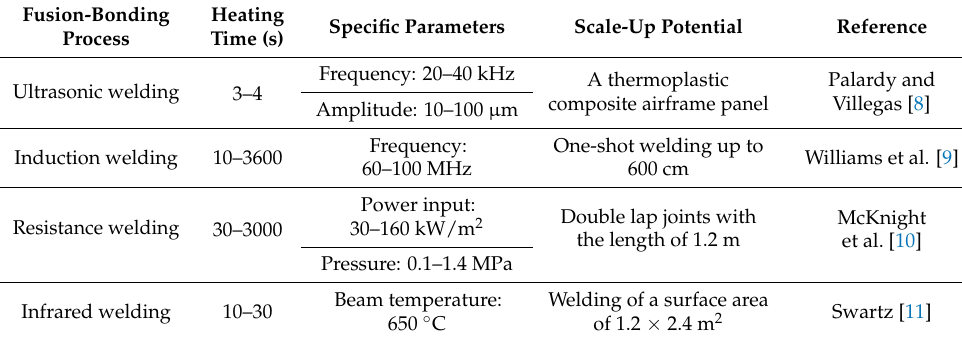
Table 1. Important welding factors for fusion welding processes.